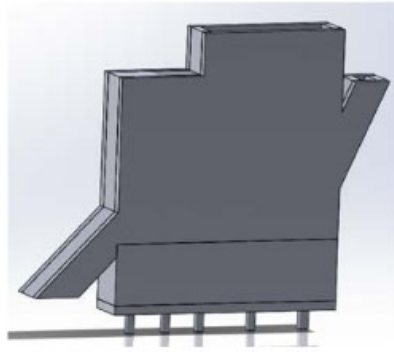
Figure 4. Classifier with front plate (transparent).